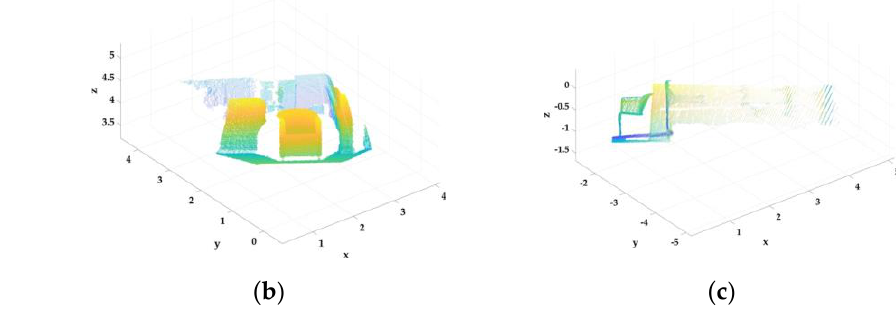
Figure 1. Depth image: original images. ( a ), depth image; ( b ), front view of the point cloud map of the depth image; ( c ), side view of the point cloud map of the depth image.